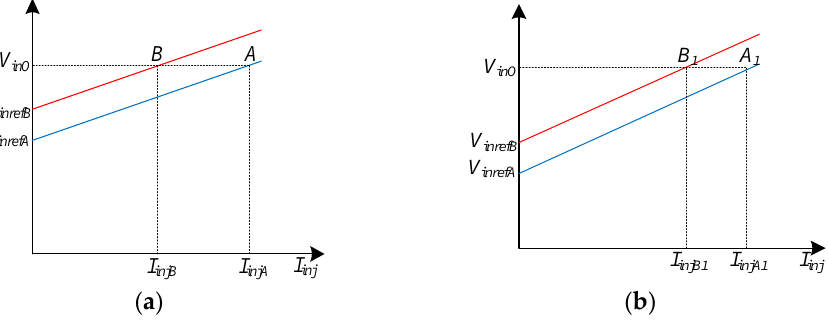
Figure 10. Distributed module current sharing characteristics: ( a ) The equilibrium coefficient K sh is small; ( b ) The equilibrium coefficient K sh is large.